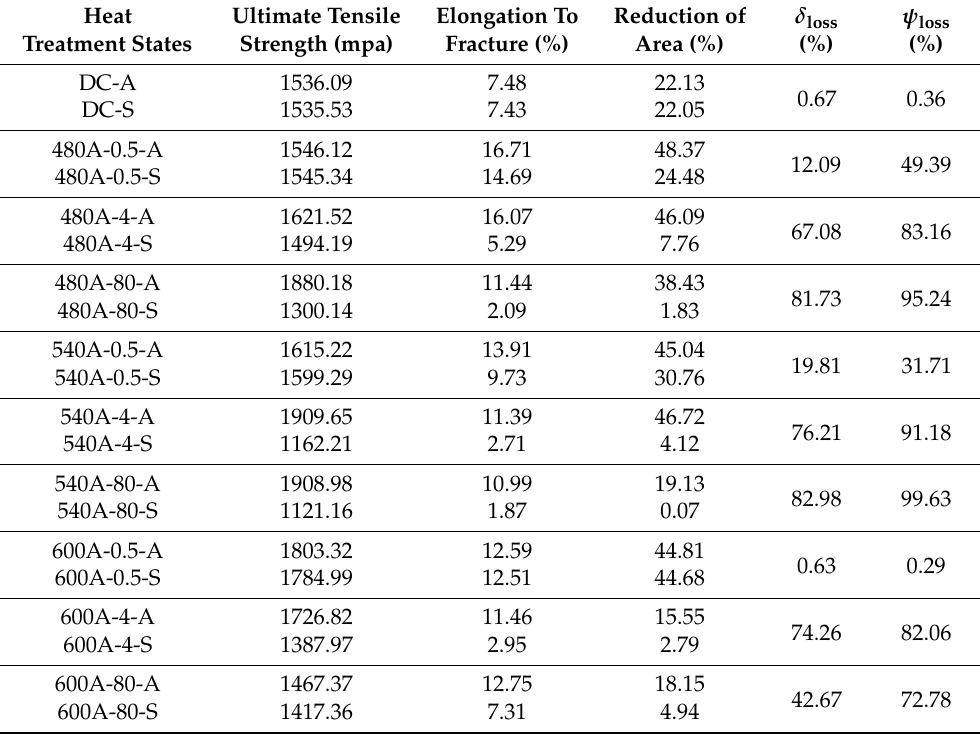
Figure 9. Engineering stress-displacement curves of the specimens in air and 3.5 wt.% NaCl solution: ( a ) DC, ( b ) 480A-0.5/480A-4/480A-80, ( c ) 540A-0.5/540A-4/540A-80, and ( d ) 600A-0.5/600A-4/600A-80. Table 4. Mechanical properties of the specimens under various thermal conditions in air and 3.5 wt.% NaCl solution.